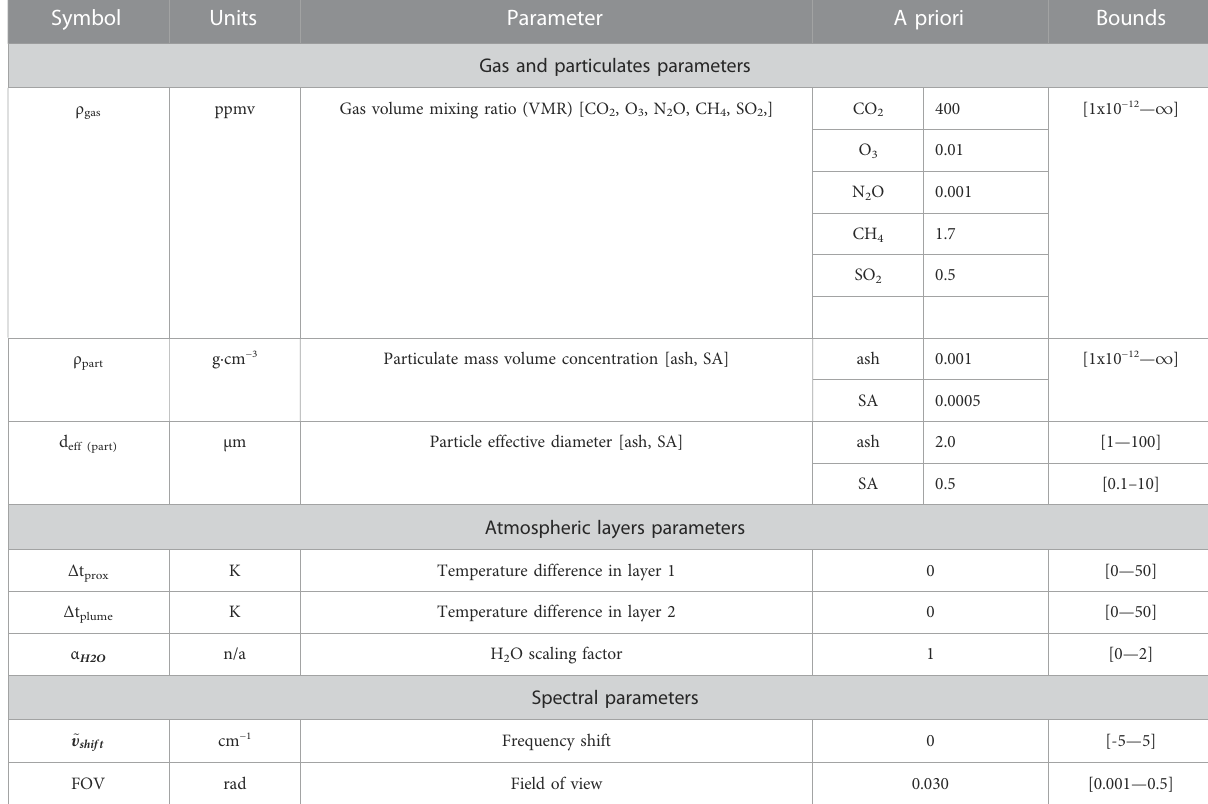
TABLE 1 Retrieved parameters for the forward model along with their bounds and a priori